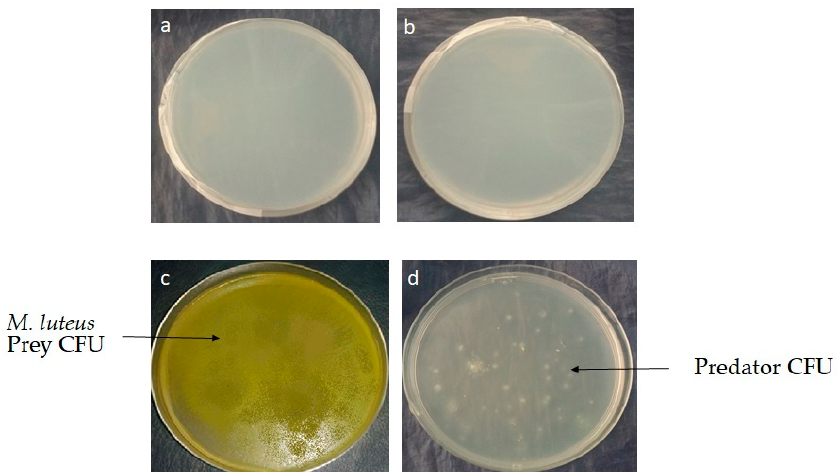
Figure 1. Predator isolation procedures and controls. ( a ) Plating of 1 mL of Micrococcus luteus at the concentration 10 12 colony-forming units (CFU)/mL embedded in 20 mL of molten agar-agar at 45 °C: no growth detected; ( b ) plating of 100 µl of a water marine sample dilution on the surface of 20 mL of agar-agar: no growth detected; ( c ) growth of 1 mL of M. luteus at the concentration 10 12 CFU/mL embedded in 20 mL of molten agar-agar at 45 °C flooded by 1 mL of nutrient broth; ( d ) growth of potential predators able to use M. luteus as a nutritional source .